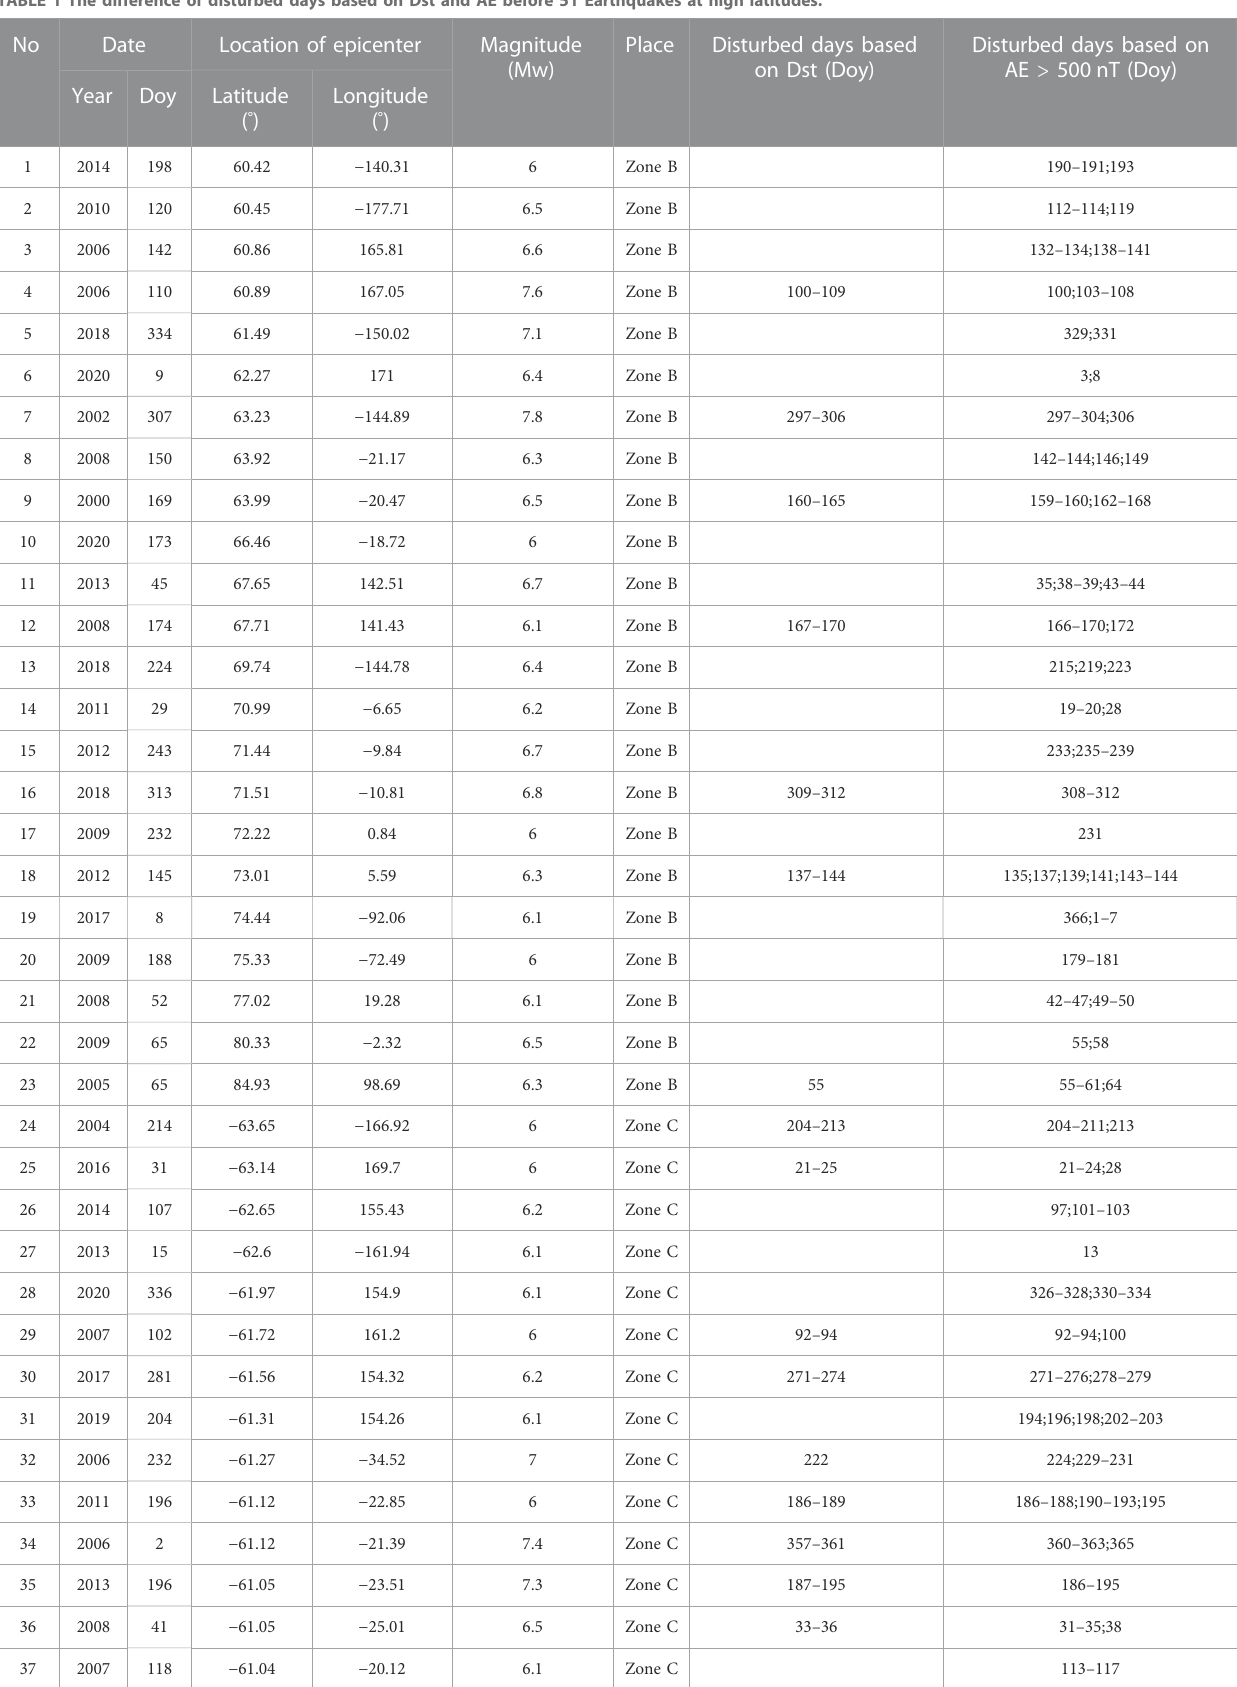
TABLE 1 The difference of disturbed days based on Dst and AE before 51 Earthquakes at high latitudes. No Date Location of epicenter Magnitude Place Disturbed days based Disturbed days based on (Mw) on Dst (Doy) AE > 500 nT (Doy) Latitude Longitude ( ° ) ( °